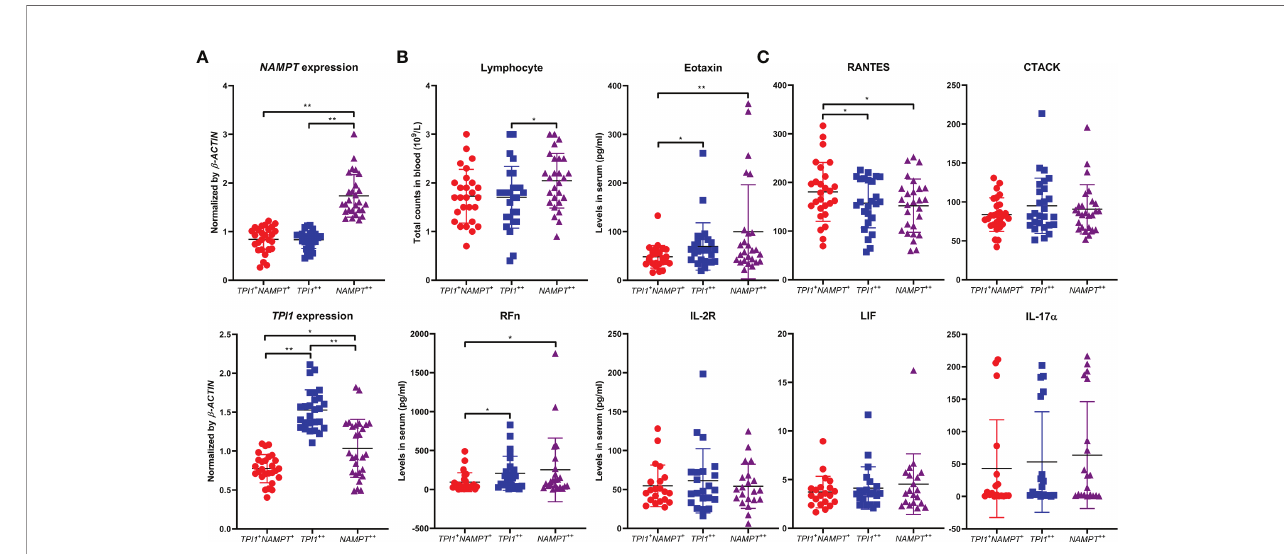
FIGURE 8 | Similar impacts of NAMPT and TPI1 overexpression on RA manifestation. (A) overview of NAMPT and TPI1 expression in WBCs from different RA subgroups; (B) differences of lymphocyte count and RFn concentration among subgroups; (C) levels of some representative cytokines-(un)related to NAMPT / TPI1 expression in blood. The statistical signi fi cance p values < 0.05* or 0.01** were calculated between groups matched by